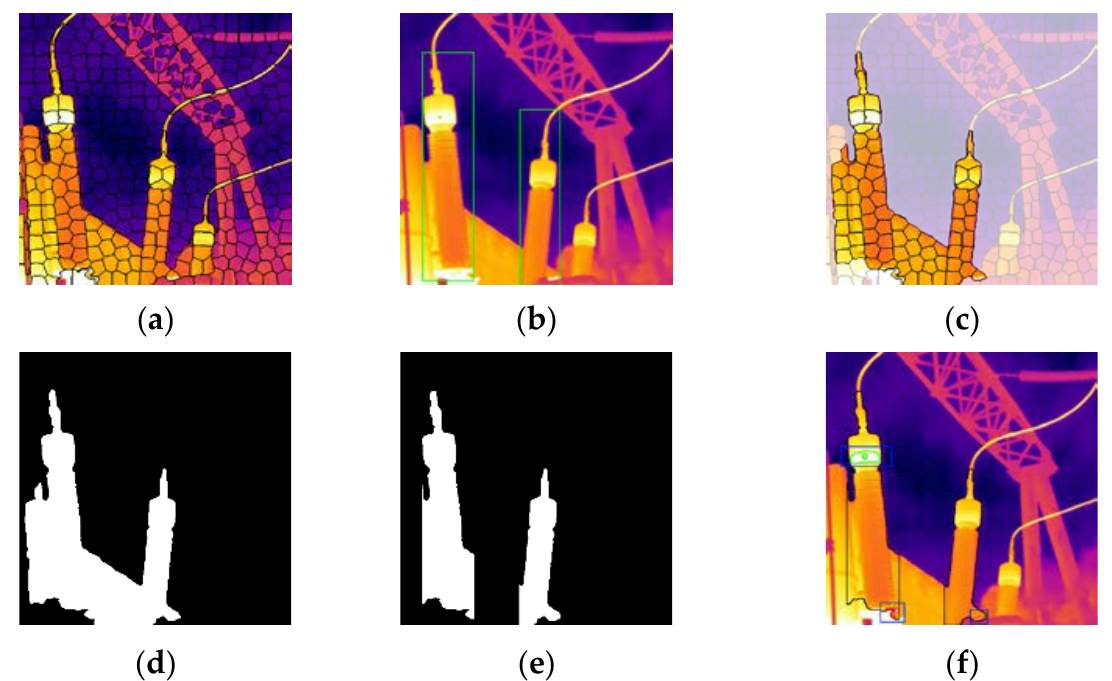
Figure 8. The results of each step in the process of diagnosis by Keys’ method ( a ) Super pixel segmentation ( b ) Image recognition ( c ) Super pixel binning ( d ) Image segmentation ( e ) Area to be inspected ( f ) Diagnosis result.